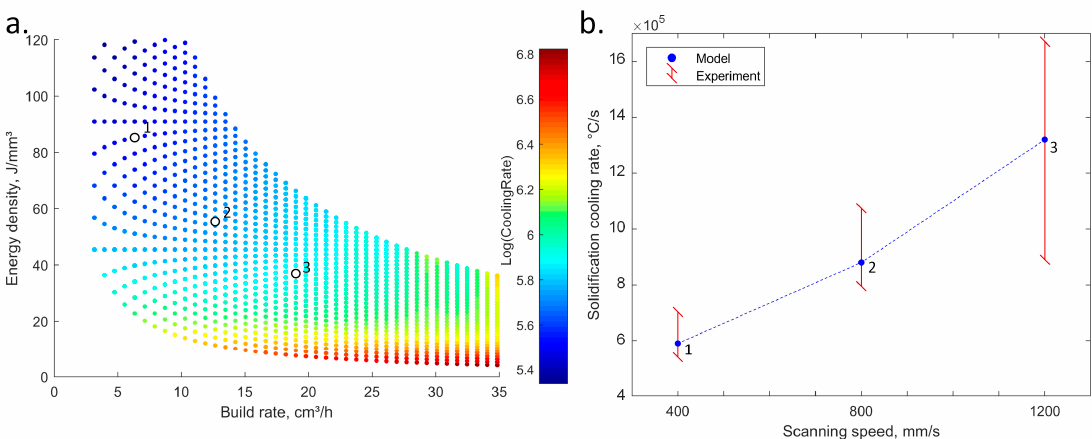
Figure 10. Comparison of the calculated and experimental CRs for IN625: ( a ) CR processing map; ( b ) scanning speed-CR plot; numbers 1 to 3 correspond to the three parameter sets presented in Table 5. Table 5. Cooling rate model-experiment [24] comparison for IN625 alloy.